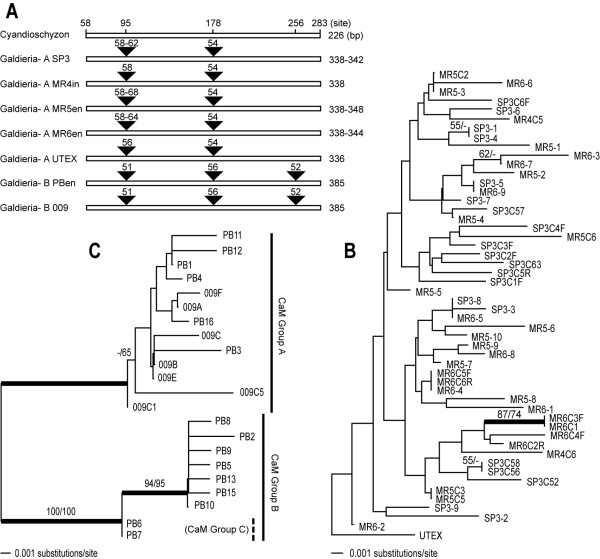
The intron positions in the CaM gene of Cyanidiales (A). Phylogeny of the Cyanidiales from Larderello (B) and Pisciarelli (C) inferred from a minimum evolution (ME) analyses of partial CaM gene sequences (including introns) using the HKY85 model. The bootstrap values shown above the branches are from ME (left of the slash mark) and MP (right of the slash mark) analyses. Only bootstrap values ≥ 50% are shown. The thick nodes represent ≥ 95% Bayesian posterior probability for clades using the GTR + I + Γ model.